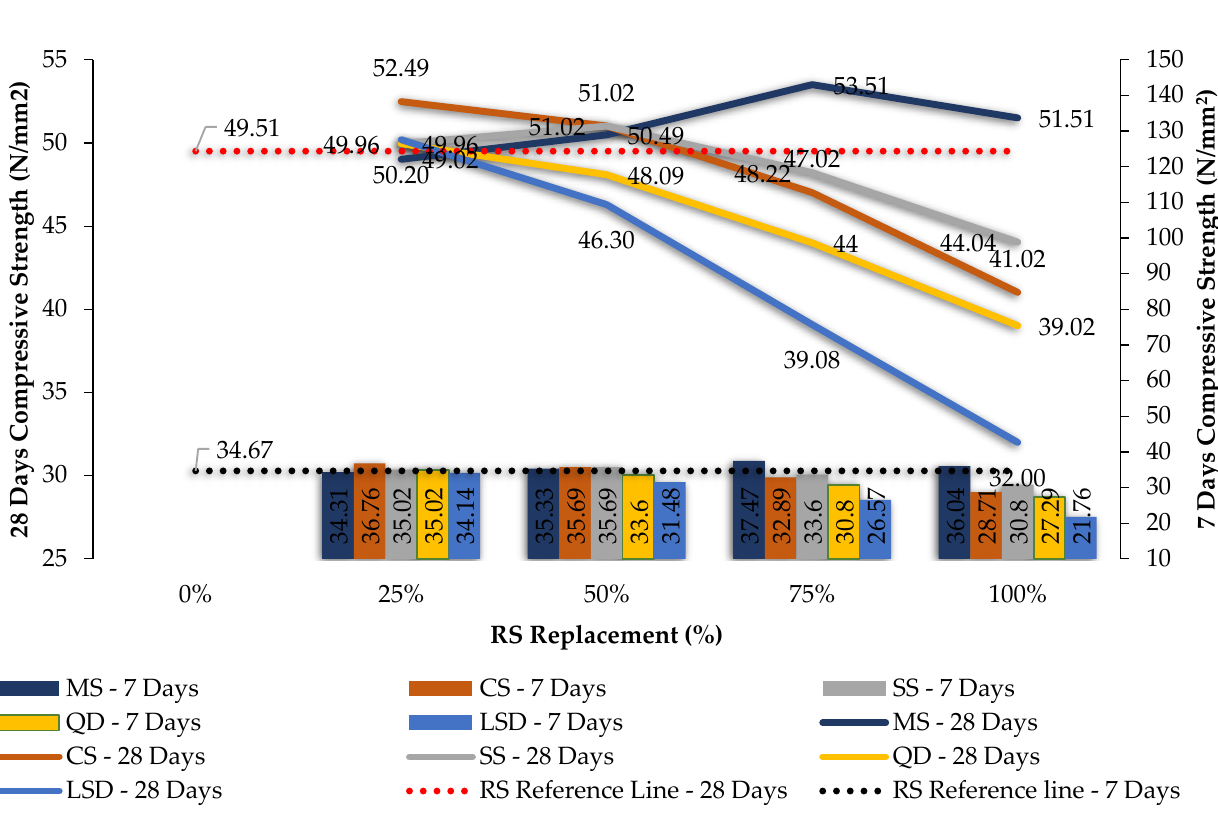
Figure 6. The 7- and 28-day split tensile test results for M 40 GPC with various fine aggregates.